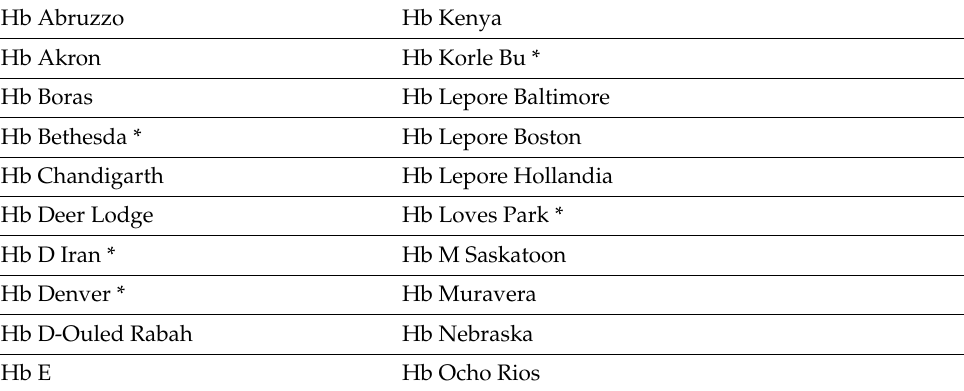
Table 5. Examples of hemoglobin variants that co-elute with or near HbA2 in